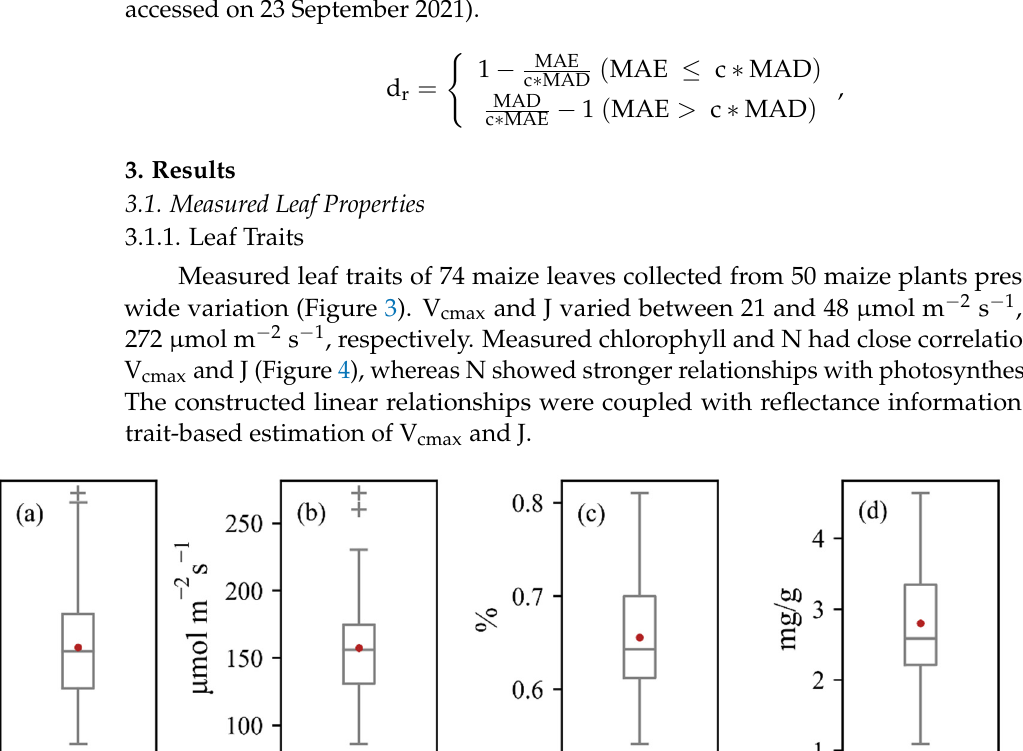
Figure 4. The relationships between biochemical parameters (chlorophyll and N) and ( a , c ) V camx and ( b , d ) J. 3.1.2. Leaf Reflectance Spectra The reflectance spectra (523–833 nm) were mainly located in the visible region, with several wavelengths belonging to the near-infrared region. Twenty wavelength bands were contained in each HSL and ASD reflectance curve since ASD data was resampled according to HSL wavelengths. The spectral spectrums derived from passive and active sensors were slightly different, and the ASD spectrum was regarded as the leaf standard reflectance curve. The red-edge region of the HSL spec- trum was not as steep as that of ASD, and the HSL reflectance was lower than ASD reflec- tance for wavelengths above 735 nm (Figure 5).